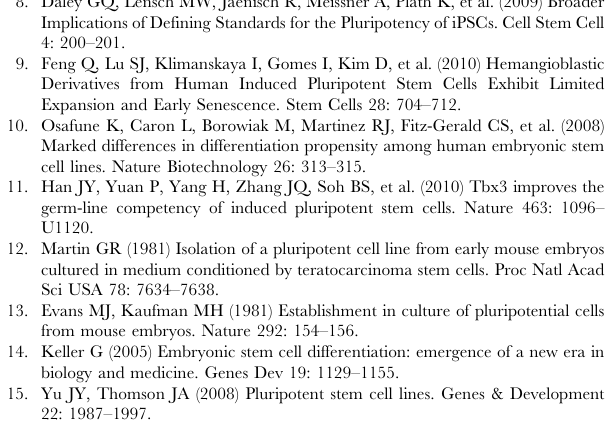
Table S3 Enriched transcription factors in response to B-MYB knockdown in ESCs identified by GSEA. A total 18,097 genes were ranked by fold-change of gene expression between the control and B-MYB knockdown in mouse ES cells R1 by microarray experiments (see materials and Methods). The ranked genes were then analyzed by GSEA based on KEGG pathways. The pathways in the table represents enriched ones for under-expressed gene set after B-MYB knockdown and with GSEA p value , 0.05 and FDR q value , 0.25. Table S4 Co-expression gene clustering in two ESC- Table S5 Global co-expression networks in ESCs under control and B-MYB deficiency conditions. A) Genes showing high connectivity in the co-expression network of the control ESCs. B) Genes showing high connectivity in the co- expression network of B-MYB knockdown ESCs. C) Most prevalent genes with differential connectivity in the co-expression networks of the control ESCs. D) Most prevalent genes with differential connectivity in the co-expression networks of B-MYB knockdown ESCs. Target genes of Oct4, Sox2, Nanog, c-Myc and E2f1 were identified by ChIP-seq or ChIP tilling array on mouse ES cells E14, J1 and V 6.5 (see Materials and Methods). 1-3O, 1- 3S, 1-3N and 1-2M represent target gene of Oct4, Sox2, Nanog and c-Myc identified at 1-3 ES cell, respectively. B-MYB target genes were identified by ChIP-chip. KD – knockdown. Table S6 ChIP-chip datasets derived from hybridiza- tions to Affymetrix GeneChip Mouse Promoter 1.0R Arrays. Table S7 Functional annotations of ChIP-chip determined B- MyB target genes based on Fisher’s exact tests and GO terms: A) functional classes with high stringency; B) functional classes – gene list with high stringency; C) functional classes with medium stringency; D) functional classes – gene list with medium stringency. Table S8 Cis -element analysis of the 1020 gene promoters that bound B-MYB and predicted frequency of these elements in genomic and promoter regions.